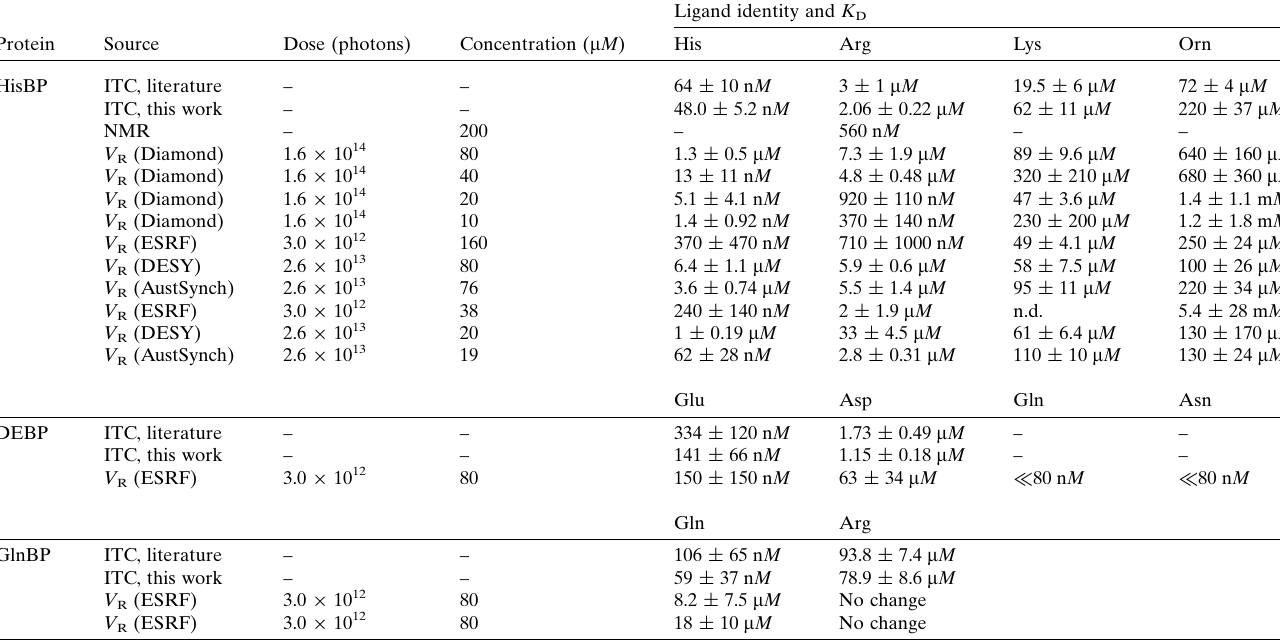
Ligand identity and K D